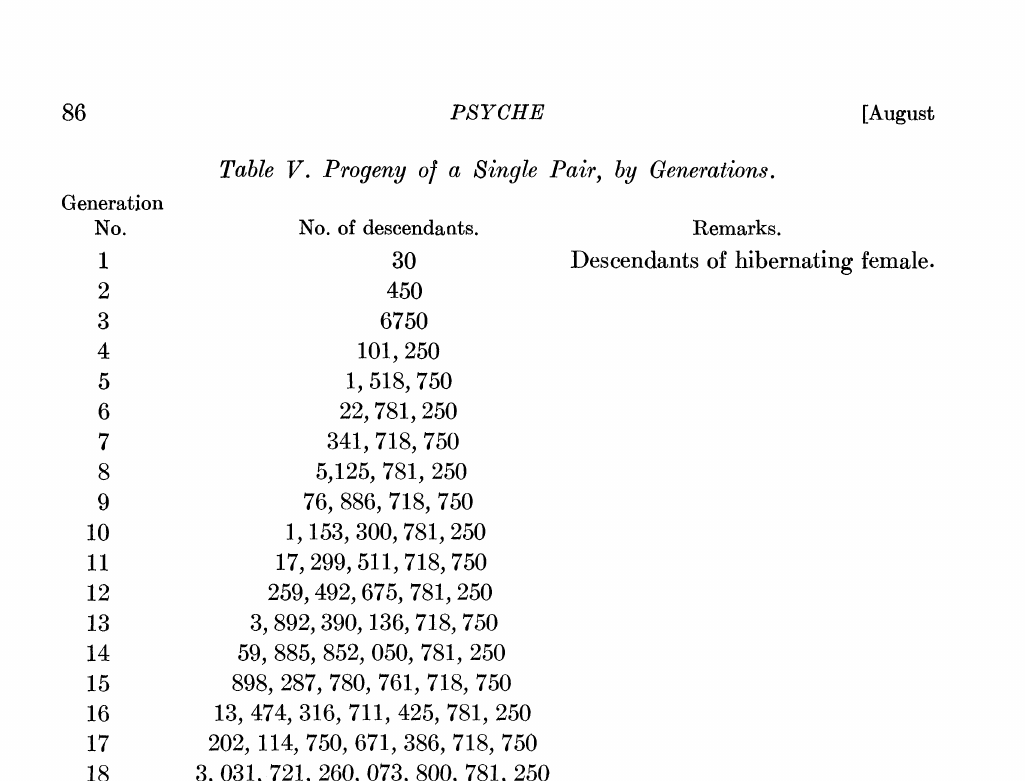
Table V. Progeny o] a Single Pair, by Generations. Generation